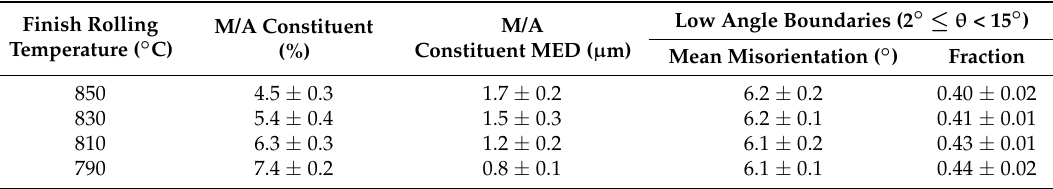
Table 2. Results of the microstructural quantification.